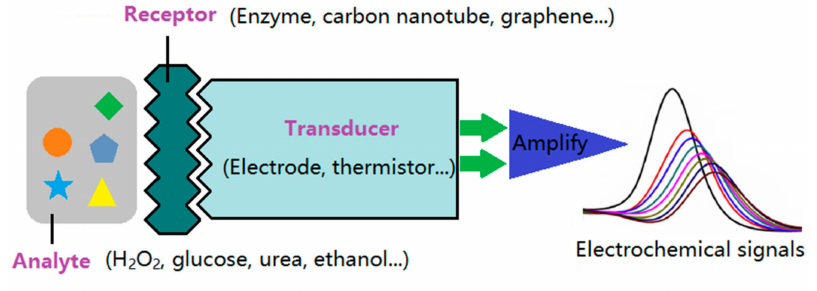
Figure 3. Schematic diagram of the electrochemical